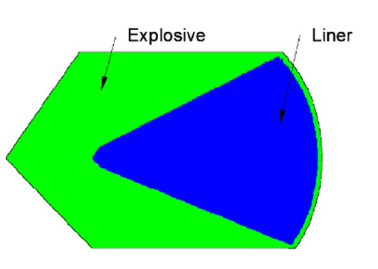
Figure 6. SPH simulation model.